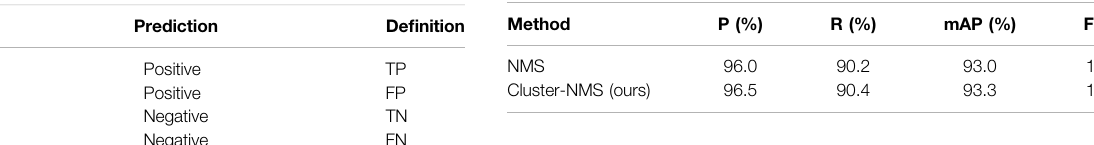
TABLE 6 | Different performances of anchor selection